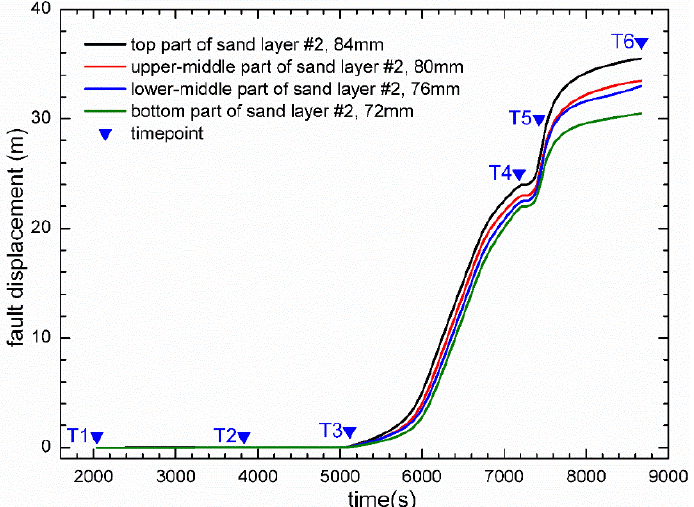
Figure 11. The fault displacement of the normal fault over time. The data from Figure 6d, between 85 mm and 110 mm in the x-coordinate and 70 mm and 90 mm in the y-coordinate. According to the previous works [47,48], the dip angle, fault displacement, and strain energy characteristics, the formation and evolution of normal fault are divided into three distinct periods in this work: the incubation period, formative period, and antithetic fault period, as shown in Table 4. Table 4. The dividing basis of the formation and evolution of normal fault periods.